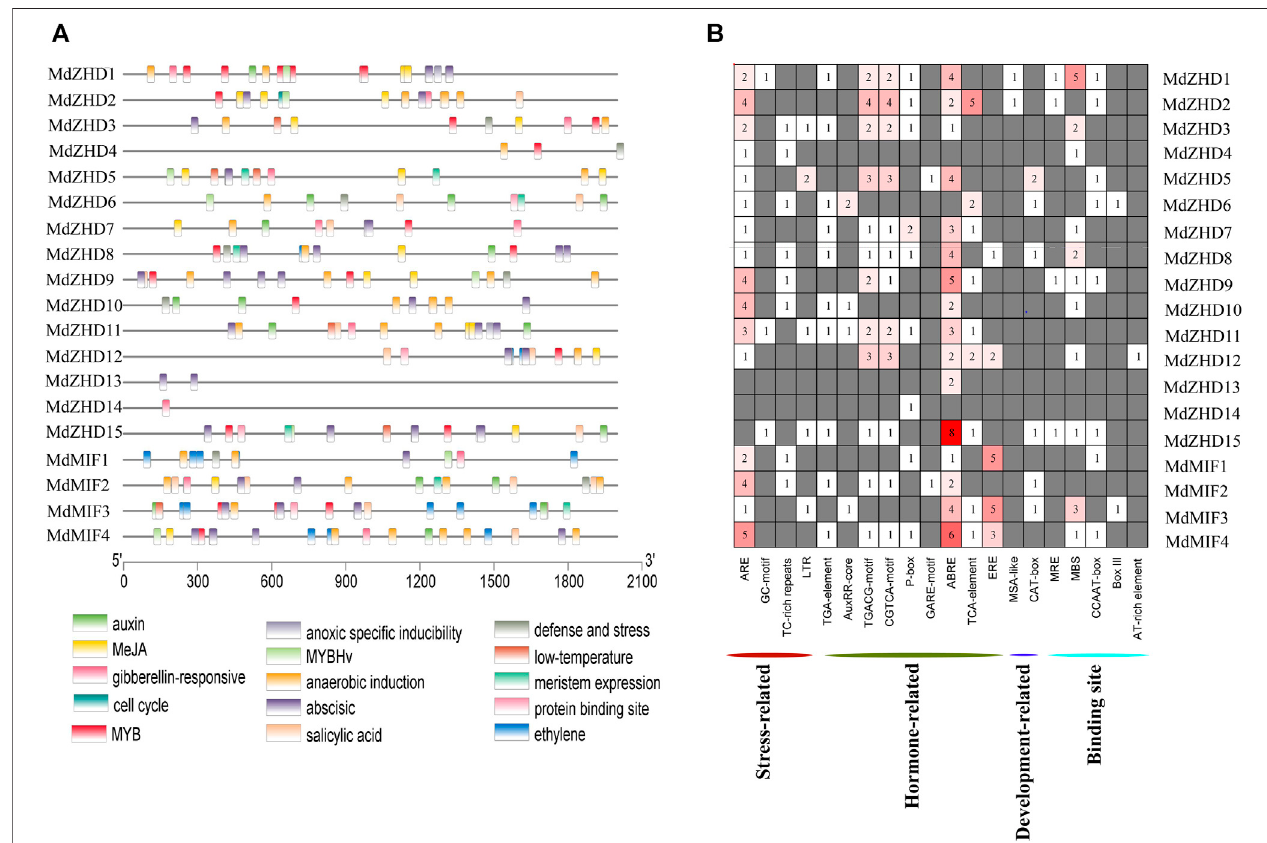
FIGURE 5 | Cis- element analysis of the promoters of MdZF-HD genes. (A) The different colored rectangles show the different types of cis -elements and their positions in each MdZF-HD gene. (B) Heatmap of the numbers of cis -elements in the promoters of MdZF-HD genes.